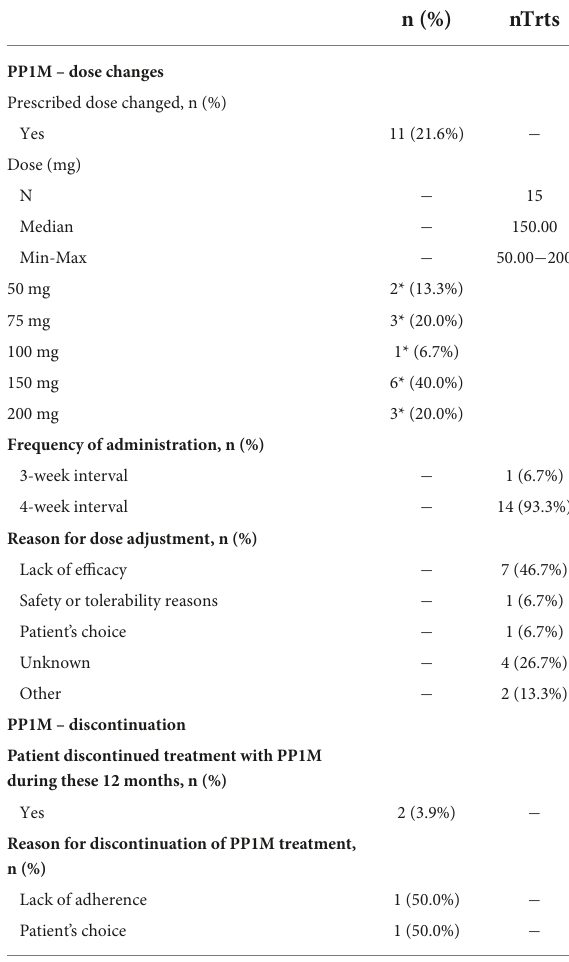
TABLE 4 Palmitate 1-month formulation treatment dose changes and discontinuation at the start of the observation period. Treatment with PP1M n (%) nTrts